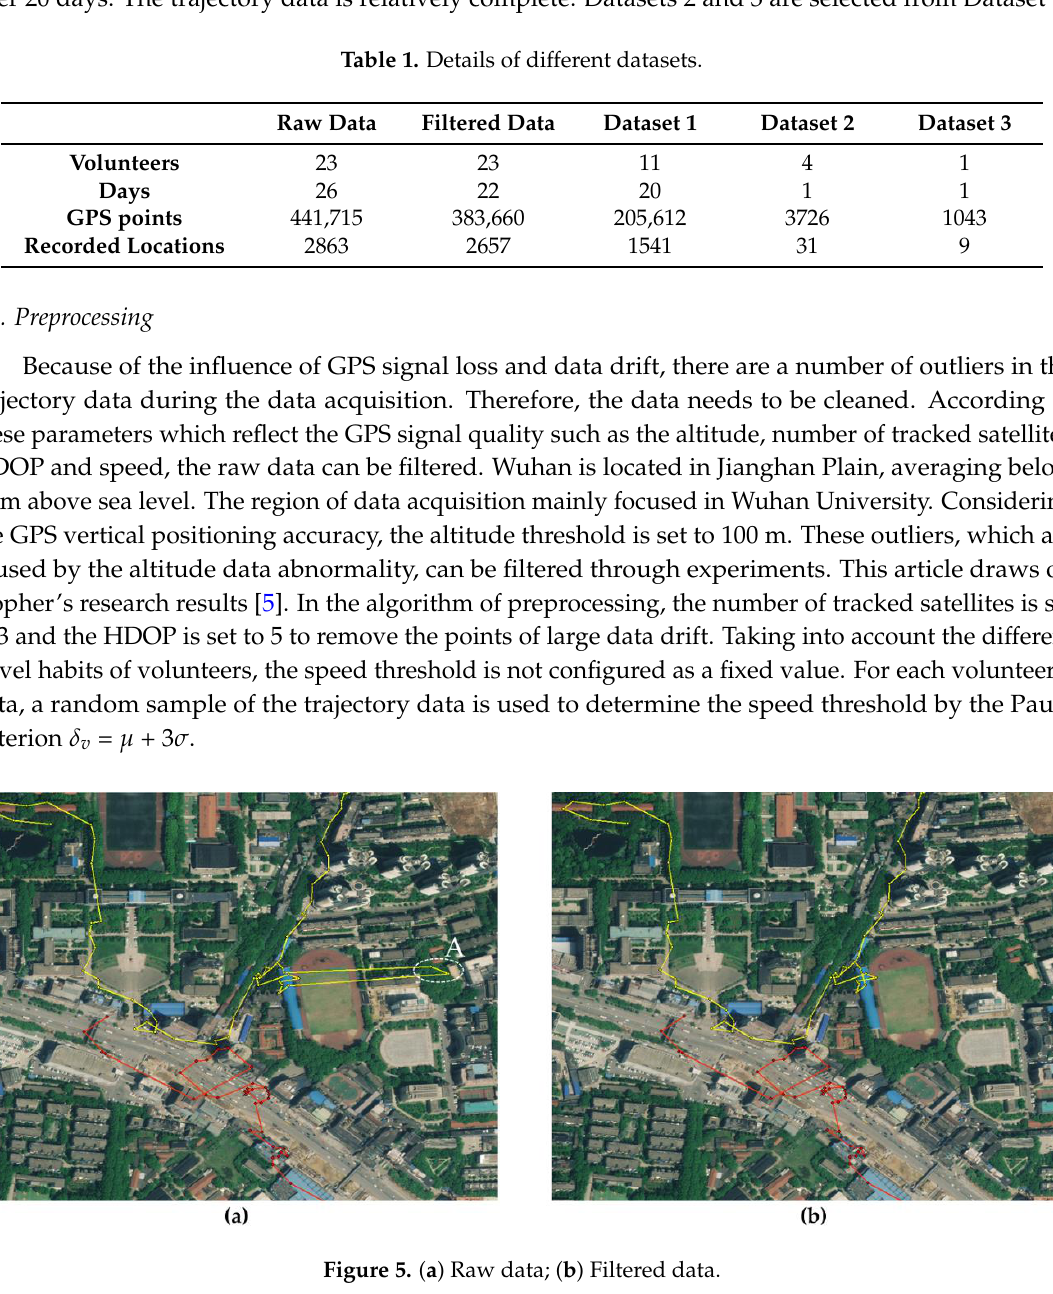
Figure 5. ( a ) Raw data; ( b ) Filtered data.